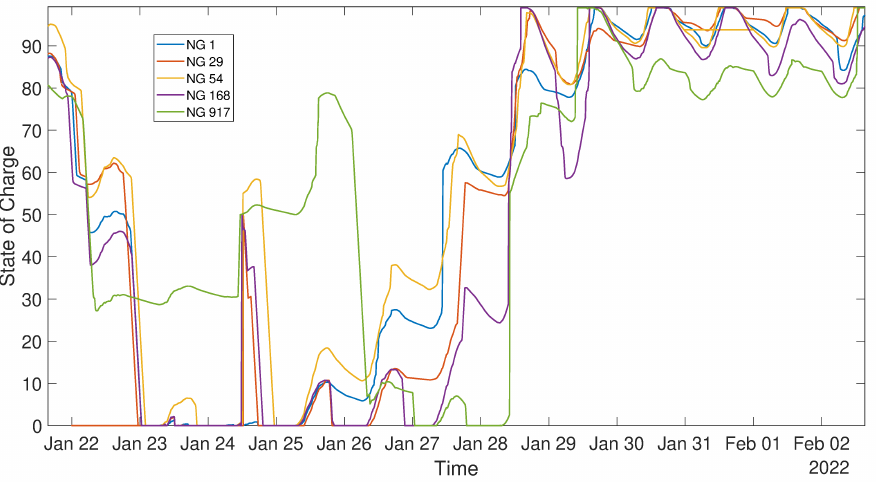
Figure 34. Evolution of the measured SoCs of the interconnected NGs during a rainy period.